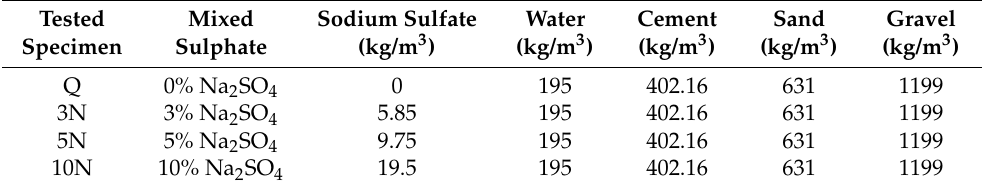
Table 2. Mix ratio of sodium sulphate